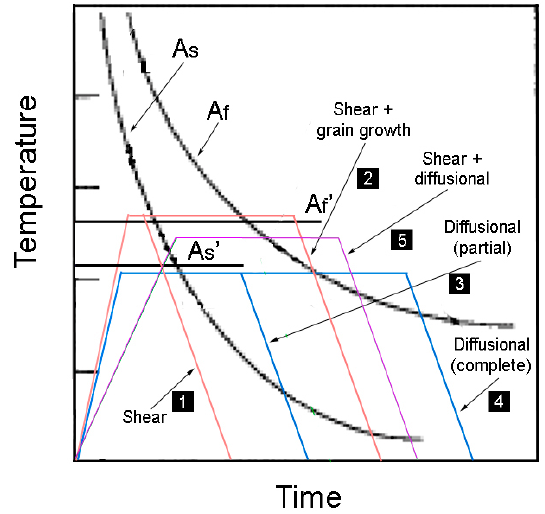
Figure 5. Thetemperaturerangeforthereversion, dependentonthereversionmechanism. Variousreversion Figure 5. The temperature range for the reversion, dependent on the reversion mechanism. Various treatments (numbered 1 ... 5) are possible. The original idea of the reversion-temperature-time diagram is reversion treatments (numbered 1…5) are possible. The original idea of the reversion-temperature- from Reference time diagram is from Reference [36].